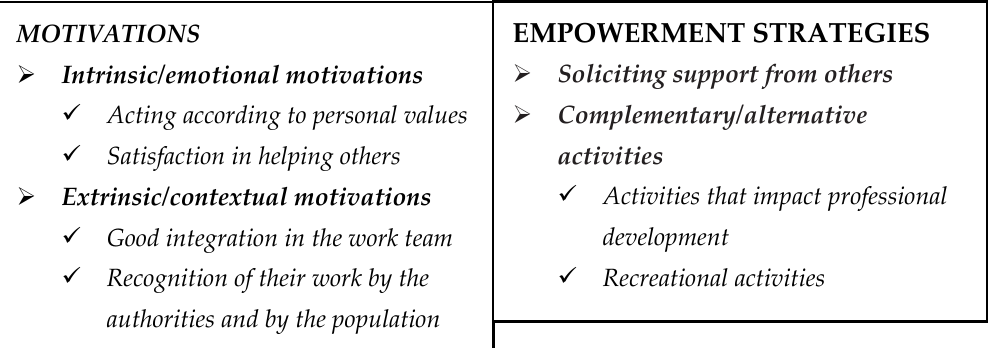
Figure 1. The model of perceptions, motivations, and empowerment strategies developed by mid- wives in rural areas of northern Morocco.